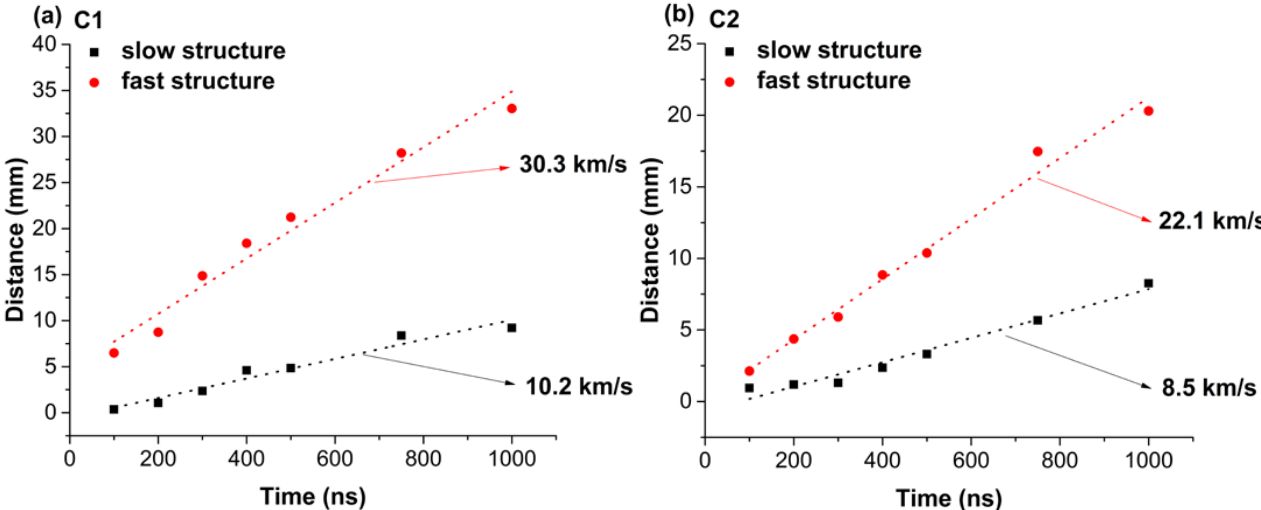
Figure 3. Space–time displacement of the two main emission maxima seen in ICCD fast camera imaging experiments. (C1 -(a));(C2 – (b)) imaging experiments. (C1-( a )); (C2-( b